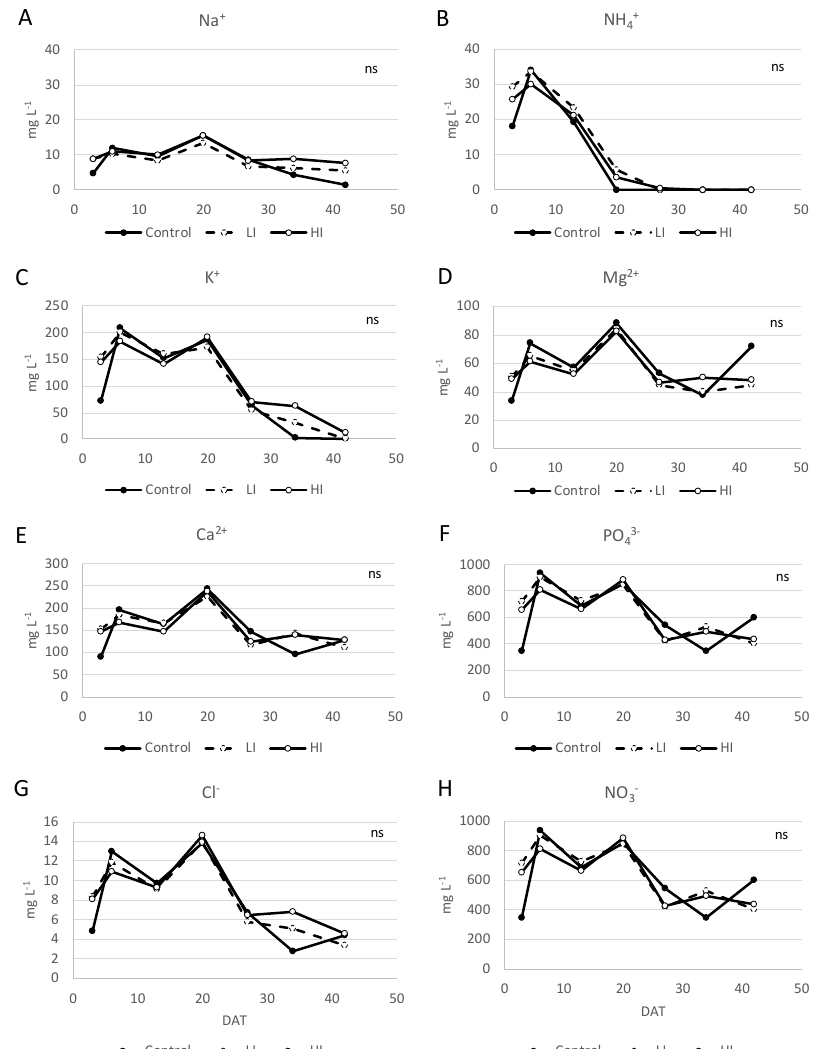
Figure 1. Evolution of the content of the main cations ( A – E ) and anions ( F – H ) present in the nutrient solution during the lettuce crop cycle in relation to treatments with non-thermal-plasma-activated nutrient solution. LI= low ionization intensity; HI= high ionization intensity; DAT= days after transplant. Within each parameter, values with different letters are significantly different at p < 0.05 based on the Tukey HSD test; ns: not significant.